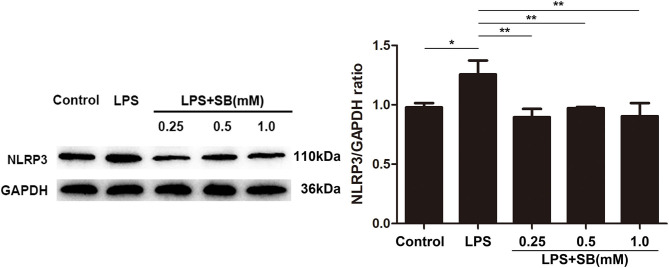
Sodium butyrate reversed the expression of NLRP3 inflammasome. After the cells were cultured with various concentrations of sodium butyrate (0.25, 0.5, 1 mM) for 12 h, and then treated with 5 μg/ml LPS for 3 h. Protein samples of NLRP3 were analyzed by Western blotting, and the quantification of the band intensity was determined by densitometry was normalized to GAPDH. Values were shown as means ± SD (n = 3). *p < 0.05, **p < 0.01 compared to the LPS group.